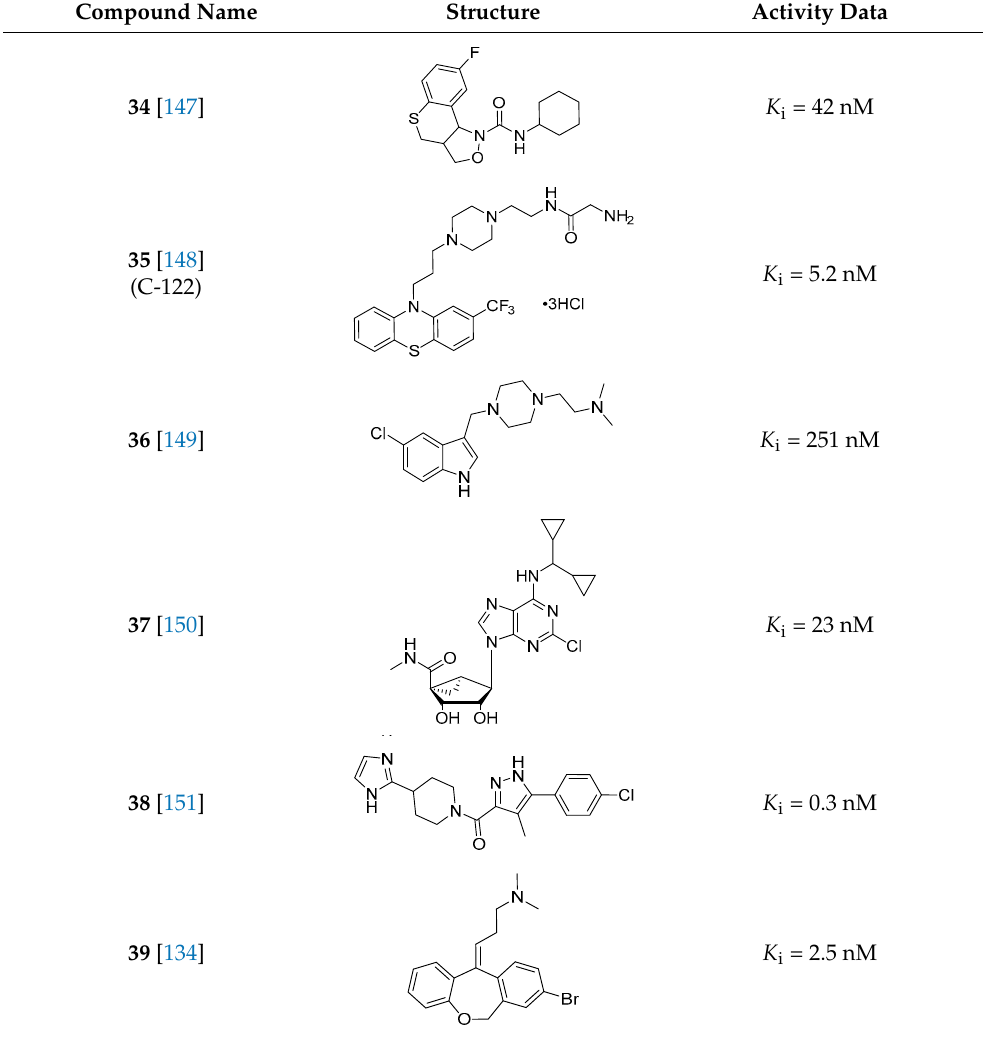
Table 3. Other representative pharmaceutical ligands of the 5-HT 2B R.